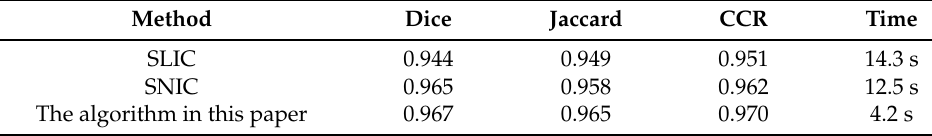
Table 2. Comparison of evaluation coefficients of liver